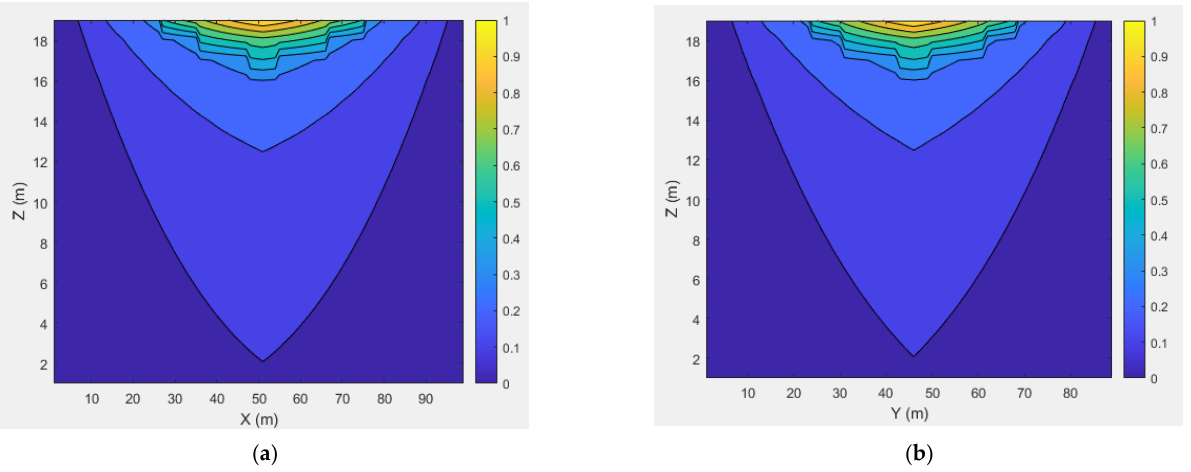
on the plane y = 45 m, ( b )  A